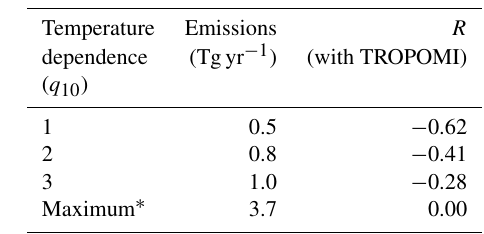
Table 3. Annual emission estimates from the Wetcharts full ensem- ble (2010) for different temperature dependencies and the correla- tion coefficient ( R ) of their respective average seasonal cycle with TROPOMI